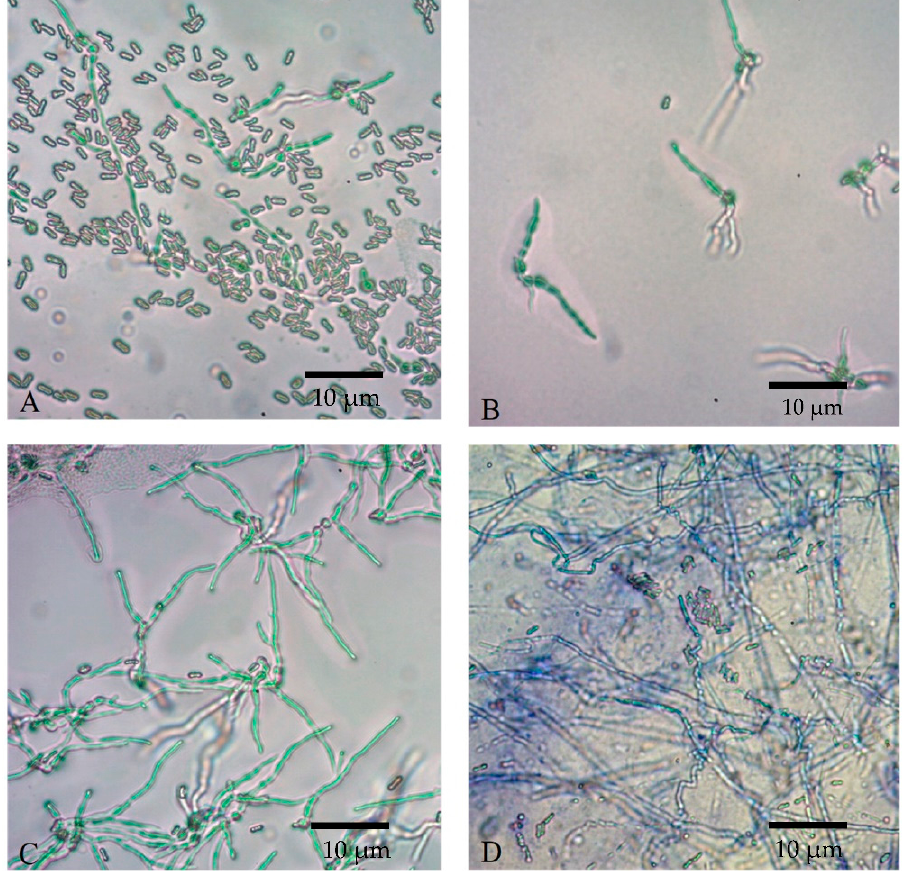
Figure 8. Conidial germination of M. anisopliae spores at 25 ◦ C at different times; ( A ) 0 h, ( B ) 4 h, ( C ) 8 h, and ( D ) 12 h at microscopic magnification of 400 ×